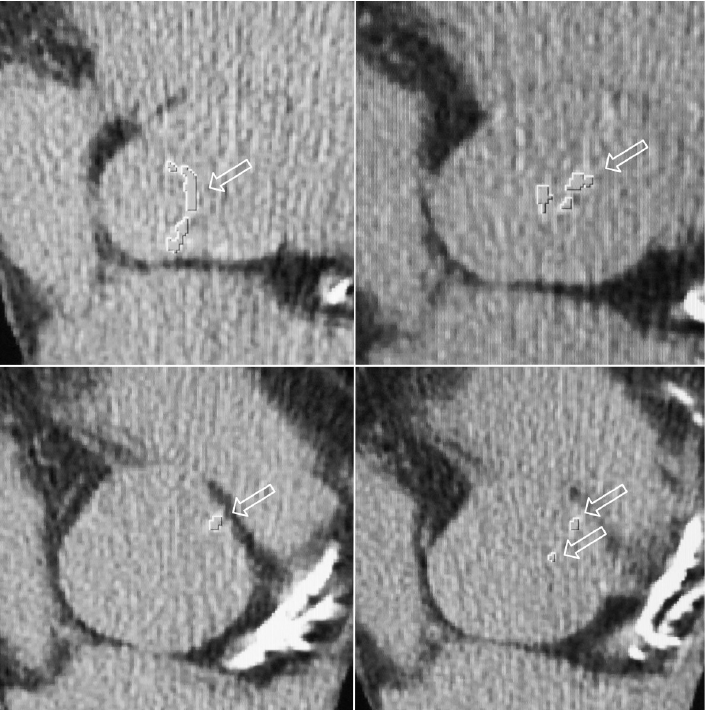
Fig 2. Computed tomography axial scans illustrating aortic valve calcifications indentified by means of SmartScore software (arrows).